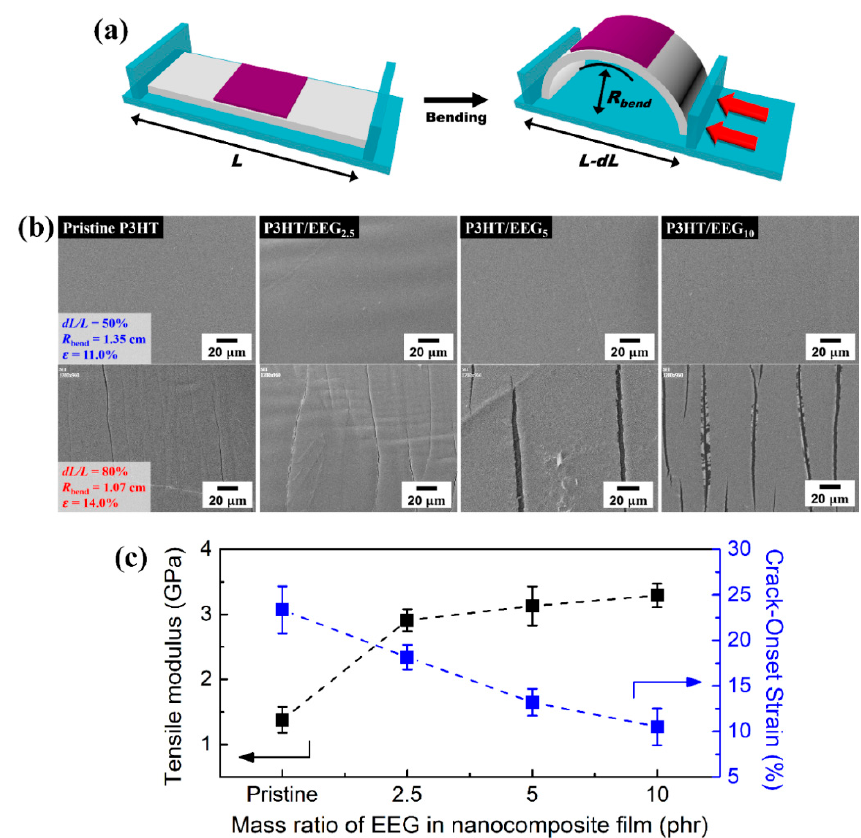
Figure 7. ( a ) Schematic illustration of bending test and ( b ) SEM images of the P3HT and P3HT / EEG nanocomposite films at bending state of dL / L = 50% ( R = 1.35 cm, ε = 11.0%) and dL / L = 80% ( R = 1.07 cm, ε = 14.0%). ( c ) Comparison between tensile modulus and crack-onset strain depending on the mass ratio of EEG in nanocomposite films.